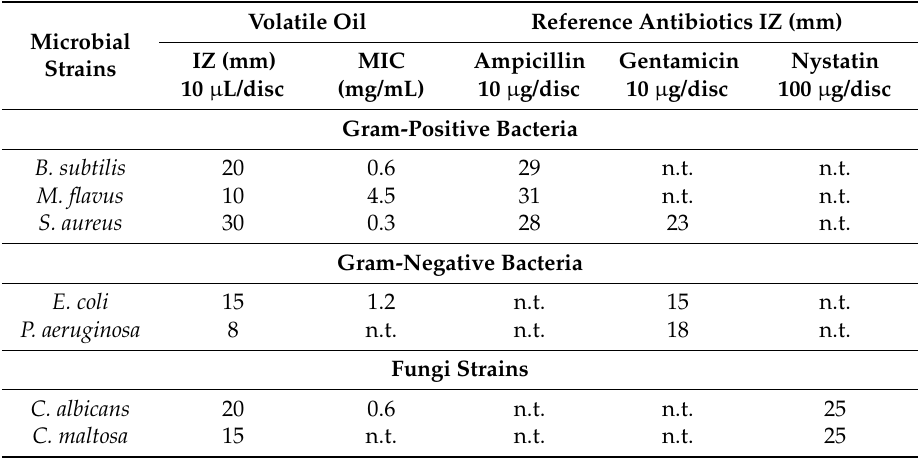
Table 2. Antimicrobial activity of the volatile oil of Ganoderma pfeifferi .